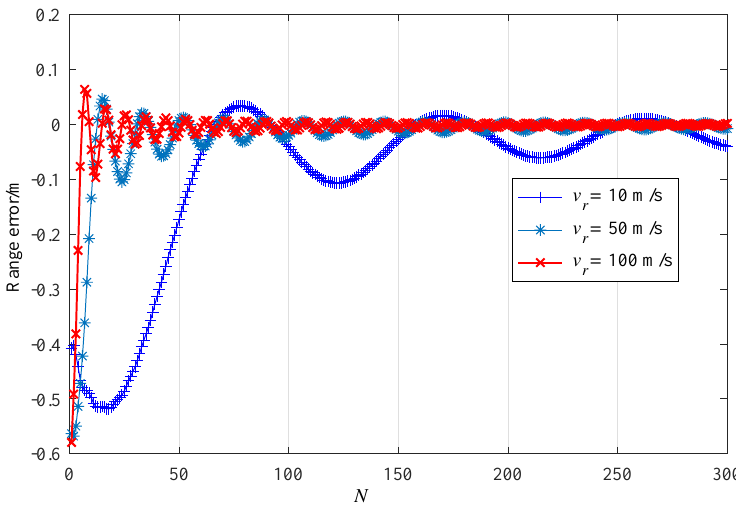
Figure 5. Range error versus N when v r = 10, 50, 100 m/s; and r = 10 m.